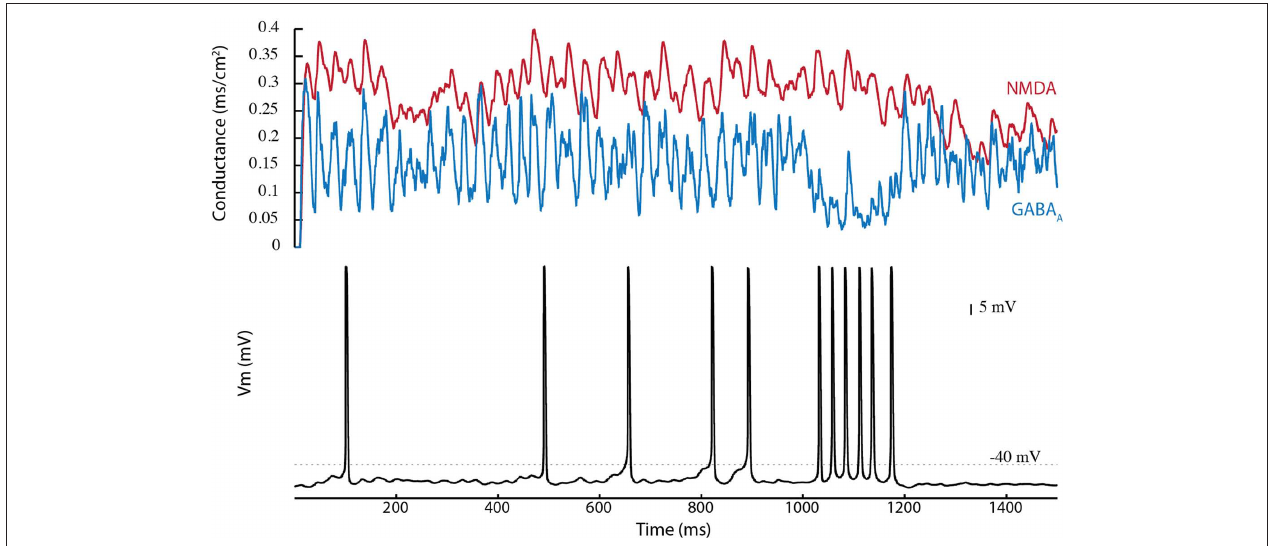
FiGure 6 | Tonic inhibition by GP reduces direct pathway mediated disinhibition bursting in the Humphries et al. (2006) model. In the Humphries model, tonic inhibition is provided by both the GP and SNpr. All connections are added except the D1STR–GP connection. Since GP and SNpr have similar firing rates, silencing of the SNpr by striatal stimulation removes approximately half of the inhibition at t = 1000 ms. Disinhibition bursts can still